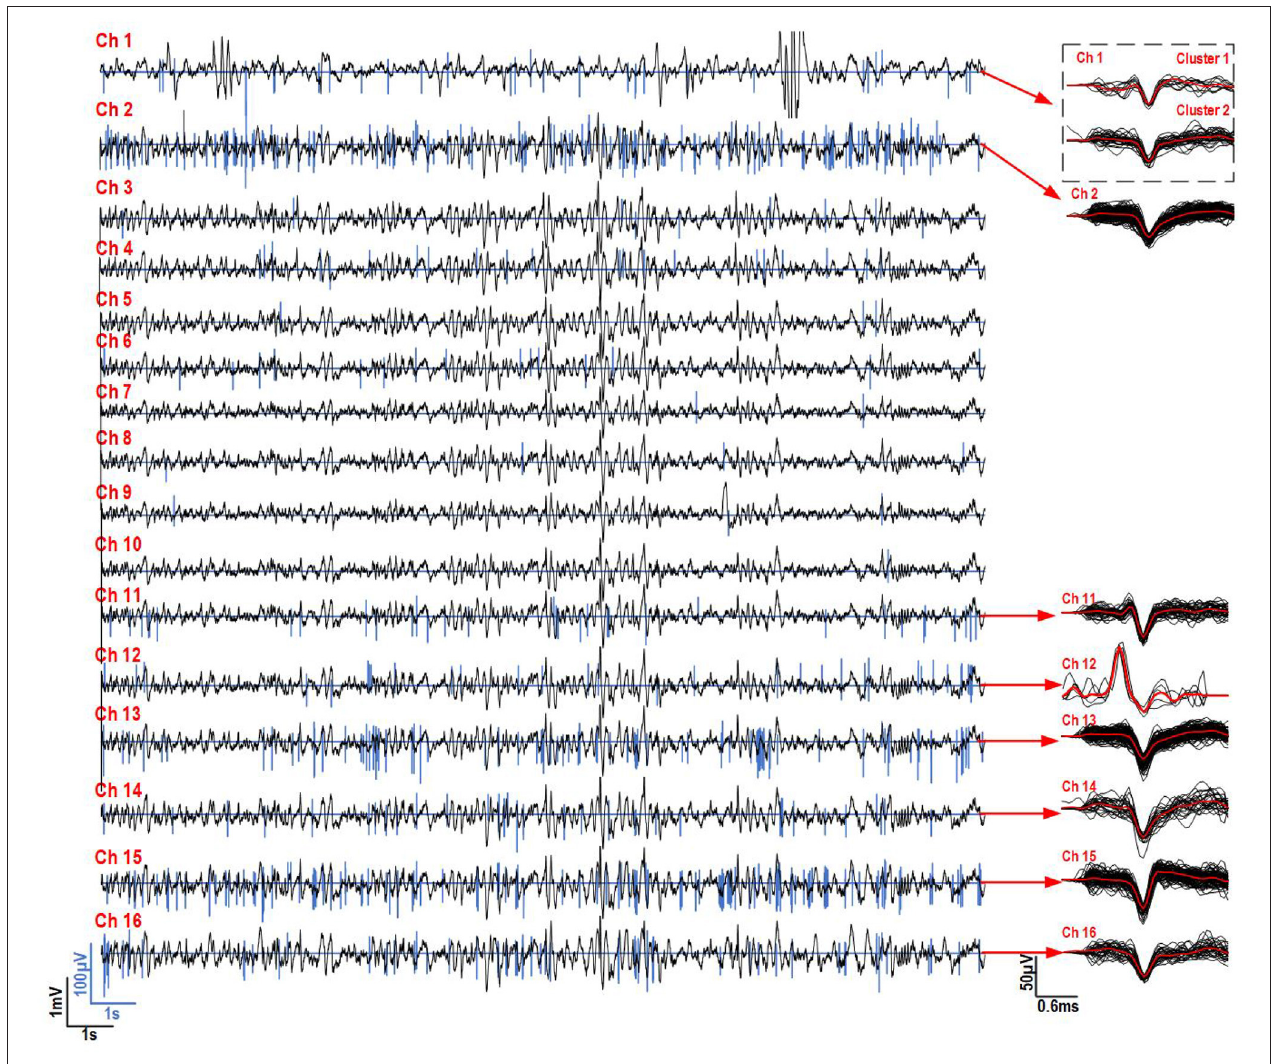
FIGURE 10 | In vivo recordings for 16 channels of both LFP and AP in the brain of a freely moving Long-Evans rat with the implant and system on its head. On the left, 20 s of recording during the experiment with the AP and LFP superimposed is shown. On the right, the clustered and superimposed APs are shown along with the average AP waveform (in red) for the channels were some activity was detected is